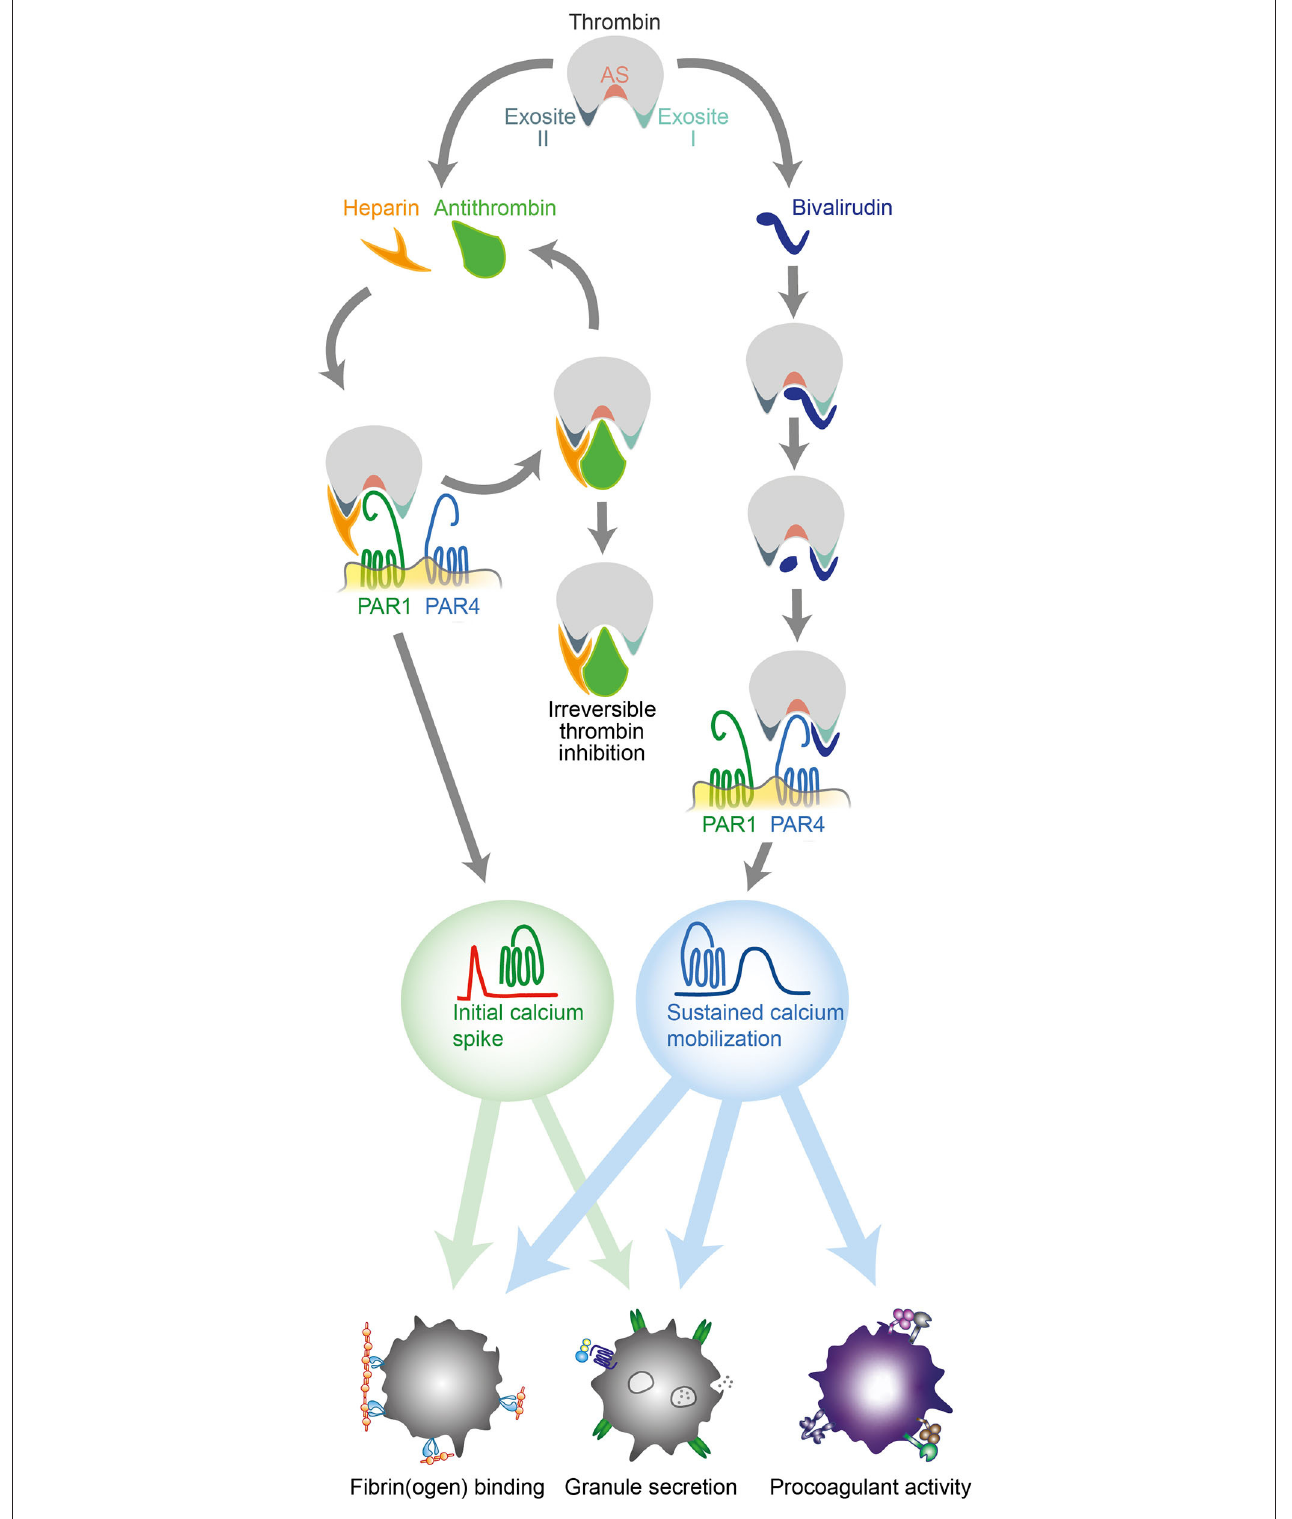
FIGURE 3 | Different effects of heparin and bivalirudin on thrombin-induced platelet activation via PAR1 and PAR4. Schematic drawing illustrating the early and late inhibitory effects of heparin/antithrombin and bivalirudin on thrombin-induced platelet activation. AT, antithrombin; PAR, protease activated receptor; Thr, thrombin.